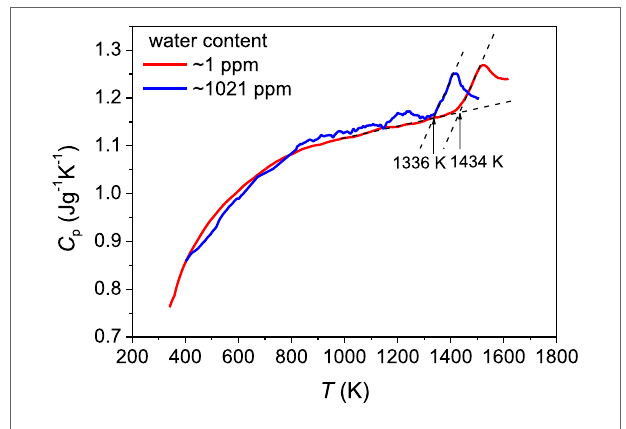
FigUre 1 | isobaric heat capacity ( C p ) measured during the second Dsc upscan as a function of temperature ( T ) for both the bulk vitreous silica with ~1 ppm hydroxyl (red line) and the vitreous silica fibers (hQsiO 2 ) with 1021 ppm hydroxyl (blue line) . The DSC upscan rate is equal to the prior downscan rate of 20